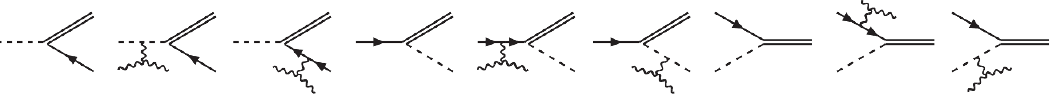
Figure 1 . Examples of 1 + n $ 2 + n scatterings contributing to the sterile neutrino spectral function (the spectral function is a cut, i.e. \amplitude squared" of such processes, convoluted with the appropriate distribution functions). Sterile neutrinos are denoted by a double line, whereas arrowed, dashed, and wiggly lines correspond to Standard Model fermions, scalars, and gauge (cid:12)elds,